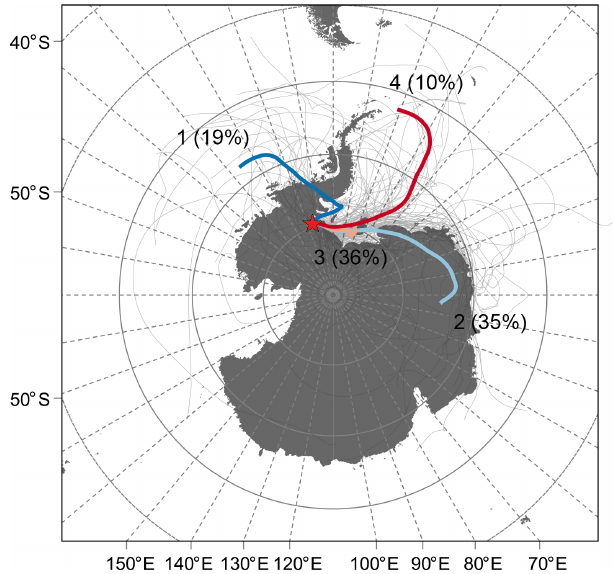
Figure 10. Cluster analysis of 5d backward trajectories transporting air masses towards the UG region (red star) as calculated for all days with precipitation events (in total 121, represented by thin grey lines) for the period 2010–2015 using the model HYSPLIT. Bold coloured lines represent the main transport pathways calculated as a percentage (%) of all trajectories associated with the respective